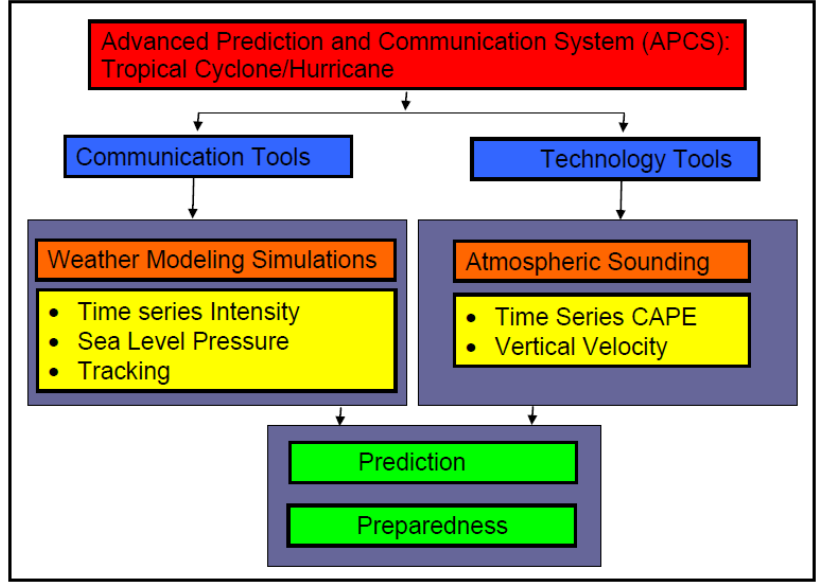
Figure 1. The proposed scheme of Advanced Prediction and Communication System (APCS) for Tropical